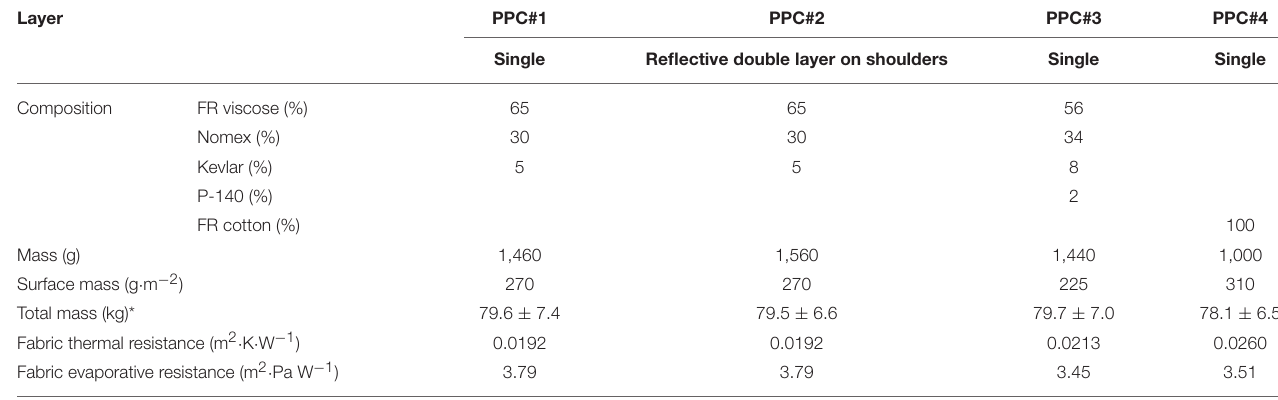
TABLE 1 | Personal protective clothing (PPC) characteristics. Layer